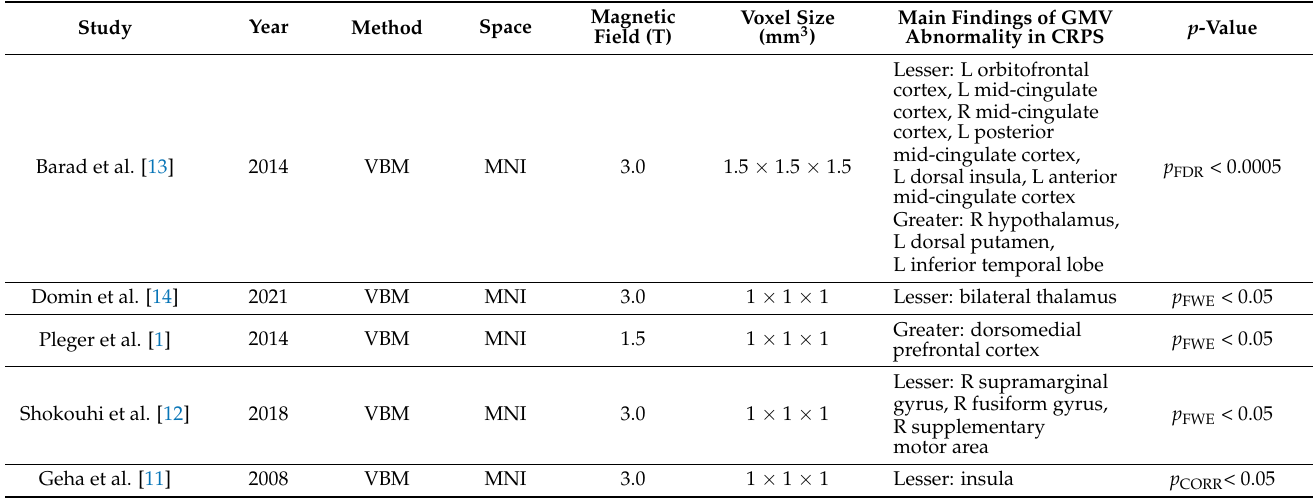
Table 2. Technical information of five studies